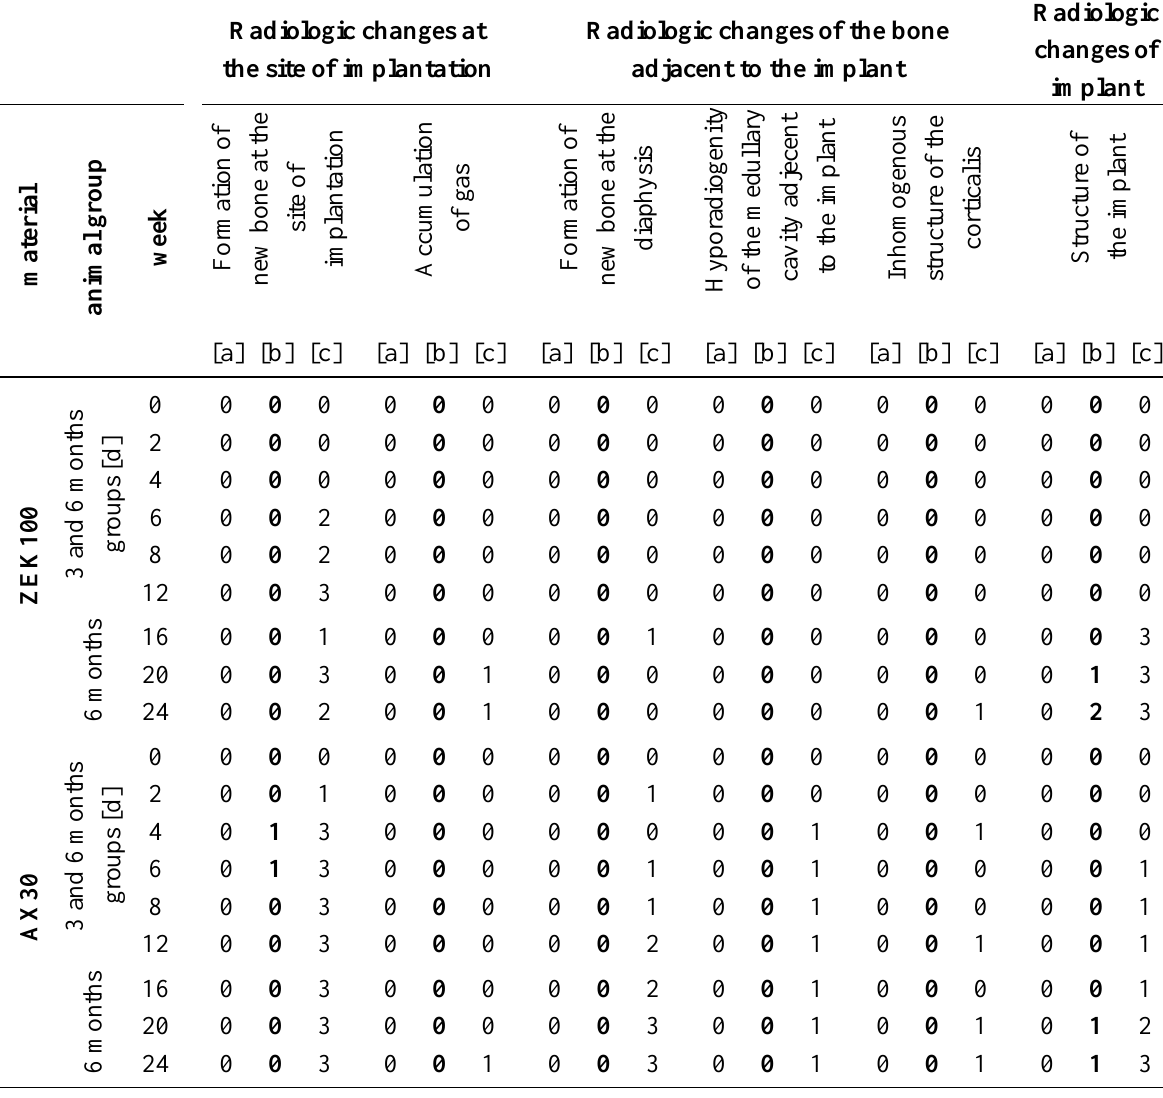
Table 1. Results of the X-ray scoring of the tibiae during the clinical follow up period. Radiologic changes at the site of implantation